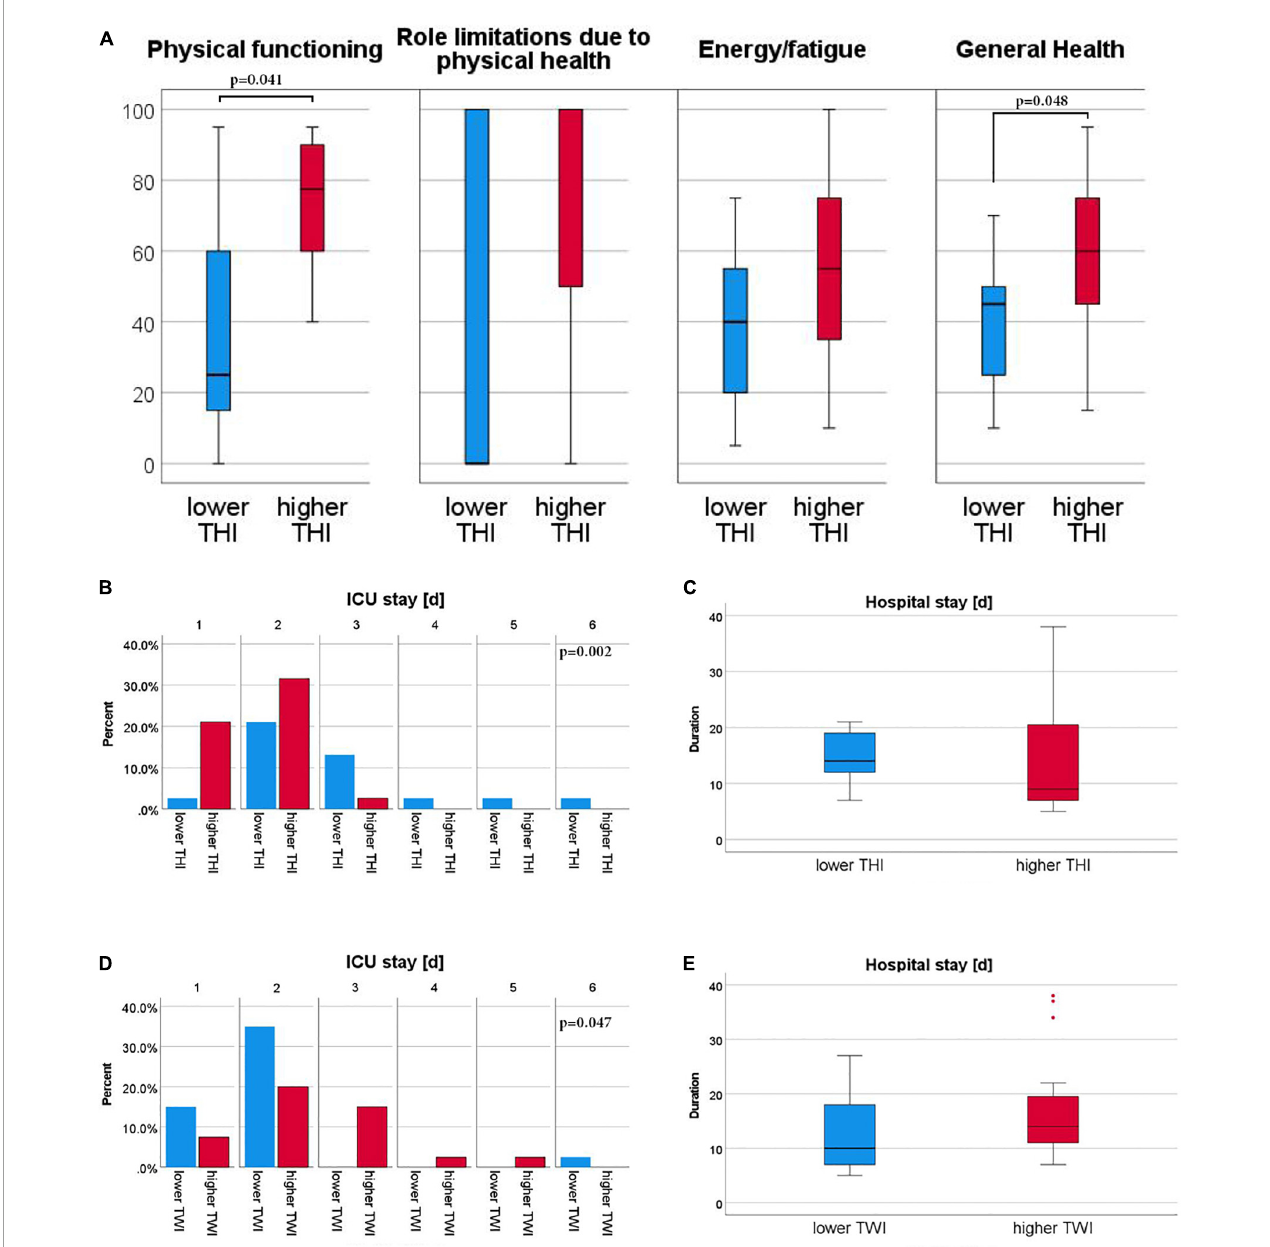
FIGURE5 Subgroup analysis for THI and SF-36 as well as subgroup analysis of THI and TWI groups for hospital and ICU stay; Patients were divided by median values of Tissue Hemoglobin Index (THI) and Tissue Water Index (TWI), respectively into a higher than or equal the median (red) and lower than median (blue) group. A total of 36-Item Short Form Health Survey (SF-36) individual scores are shown for the THI groups (A) . All Scores are given on an arbitrary scale of 0–100, high values representing the favorable health condition. Stay on Intensive Care Unit (ICU) is given by relative frequency for THI (B) and TWI (D) groups by days [d]. Hospital stay is given for THI (C) and TWI (E) subgroups in days [d]. Mann–Whitney-U test was used for comparisons between